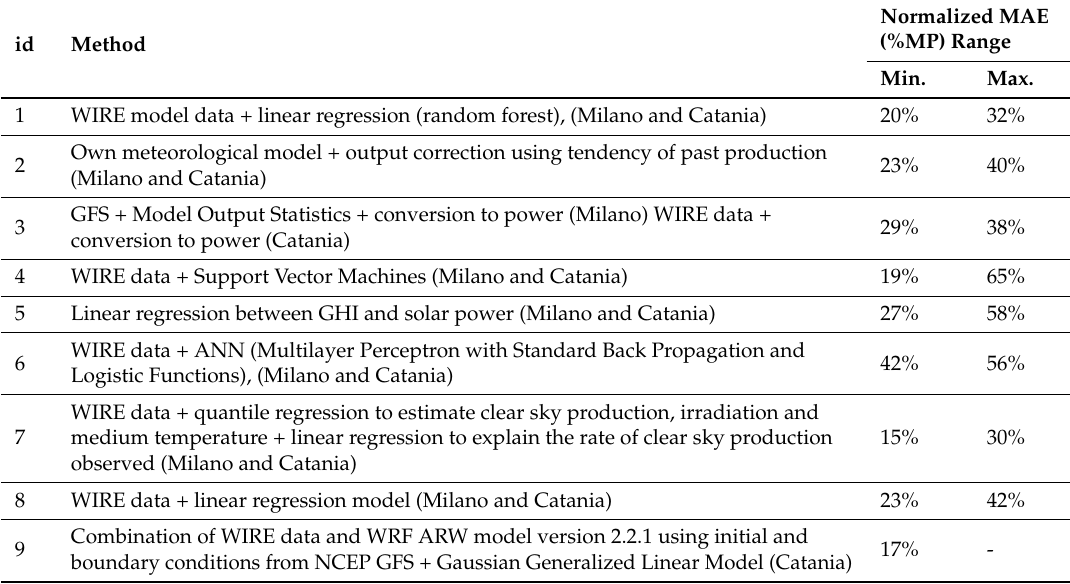
Table 7. Normalized MAE (%MP) ranges for the methods applied in [24] to Milano (IT) and Catania (IT).